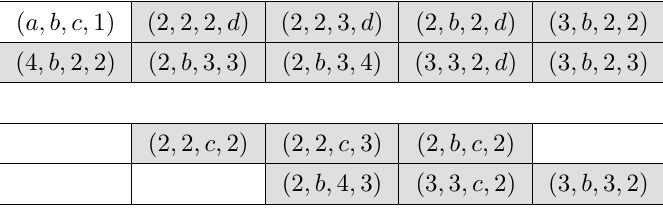
Table 8 . Infinite sequences of type V singularities. The second table is obtained from the first by exchanging c, d . The empty entries are either invariant under exchange or have c = 1 . Gray entries are reducible to previous types of singularities. This table is adapted from